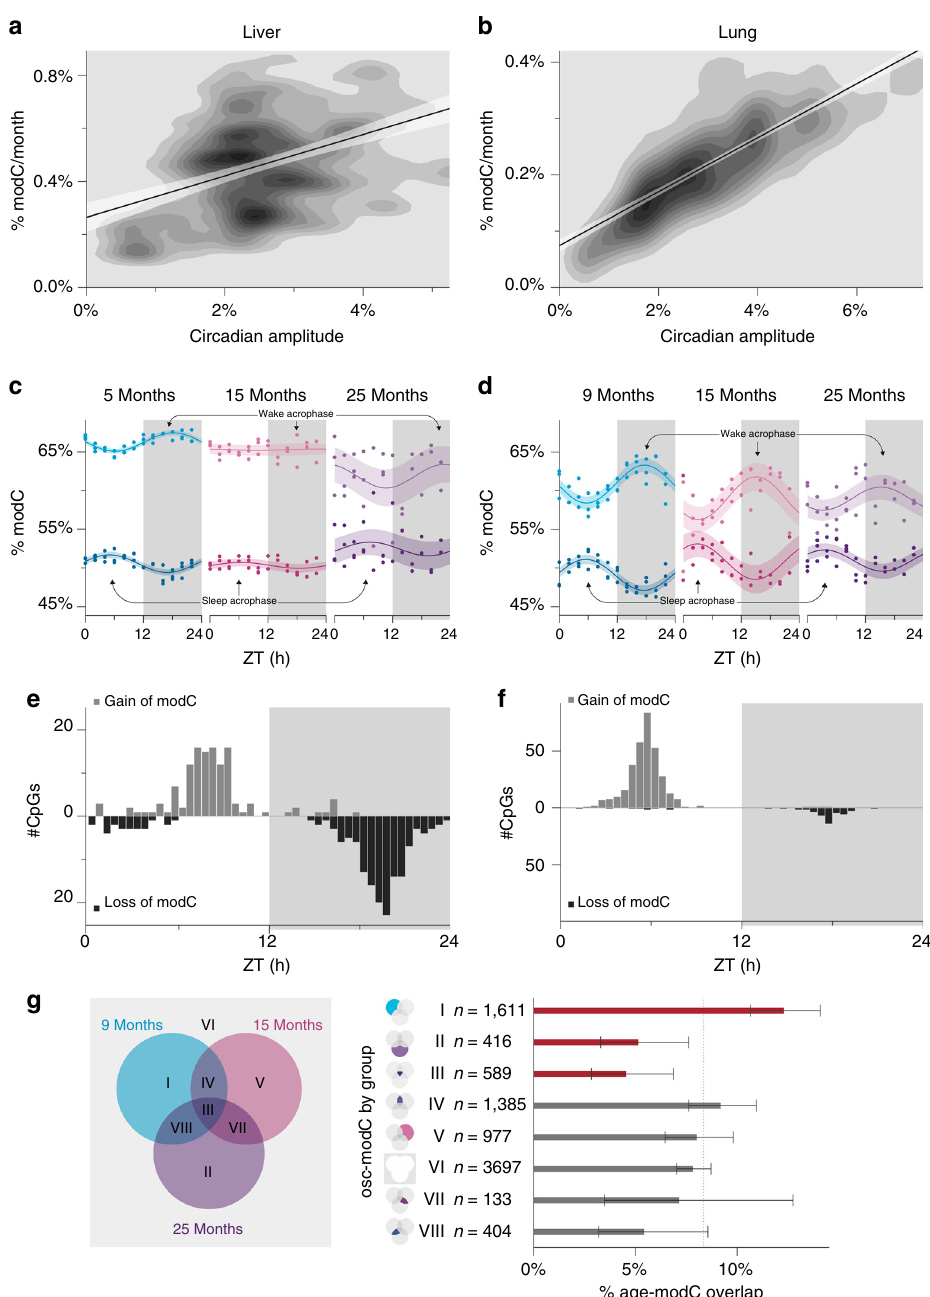
Fig. 6 The relationship between oscillating and age-correlated cytosine modi fi cations in the mouse liver and lung. a , b Density contour plots of the age- modC magnitude and the osc-modC amplitude in a the liver and b the lung. Contours were rendered using 2D kernel density estimation and the lines represent linear regression fi ts. Shading around the regression lines represents the 95% con fi dence band. c , d The mean modi fi cation levels of 9-mo osc- modCs, strati fi ed by wake and sleep acrophases, converge with increasing age in the c the liver and d the lung. The curves show harmonic regression fi ts of the mean cytosine modi fi cation and the shading around the regression lines show 95% con fi dence bands. e , f The relationship between acrophase time and aging direction in e the liver and f the lung. The white areas represent periods of lights on (i.e., sleep), whereas the shaded areas show periods of lights off (i.e., wake). The gray bars show counts of cytosines with gain of modi fi cation with age, whereas the black bars show counts for loss of modi fi cation. g Osc- modC were categorized according to their placement in the Venn diagram. The bar plots represent the percentage of cytosines in each group that were also age-modCs with 95% con fi dence intervals. The dashed line represents the expected proportion of age-modC and the red bars show signi fi cant ( p < 0.05) deviation from this expected line. Age-modC, age-correlated cytosine modi fi cations; Osc-modC, oscillating modi fi ed cytosines; modC, modi fi